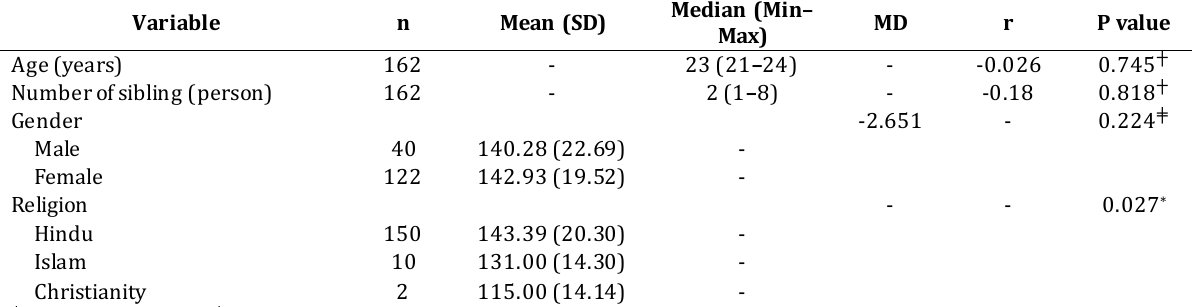
Table 5. The Relationship between Demographic Characteristics and Moral Sensitivity among Professional Nursing Students in Bali (n =